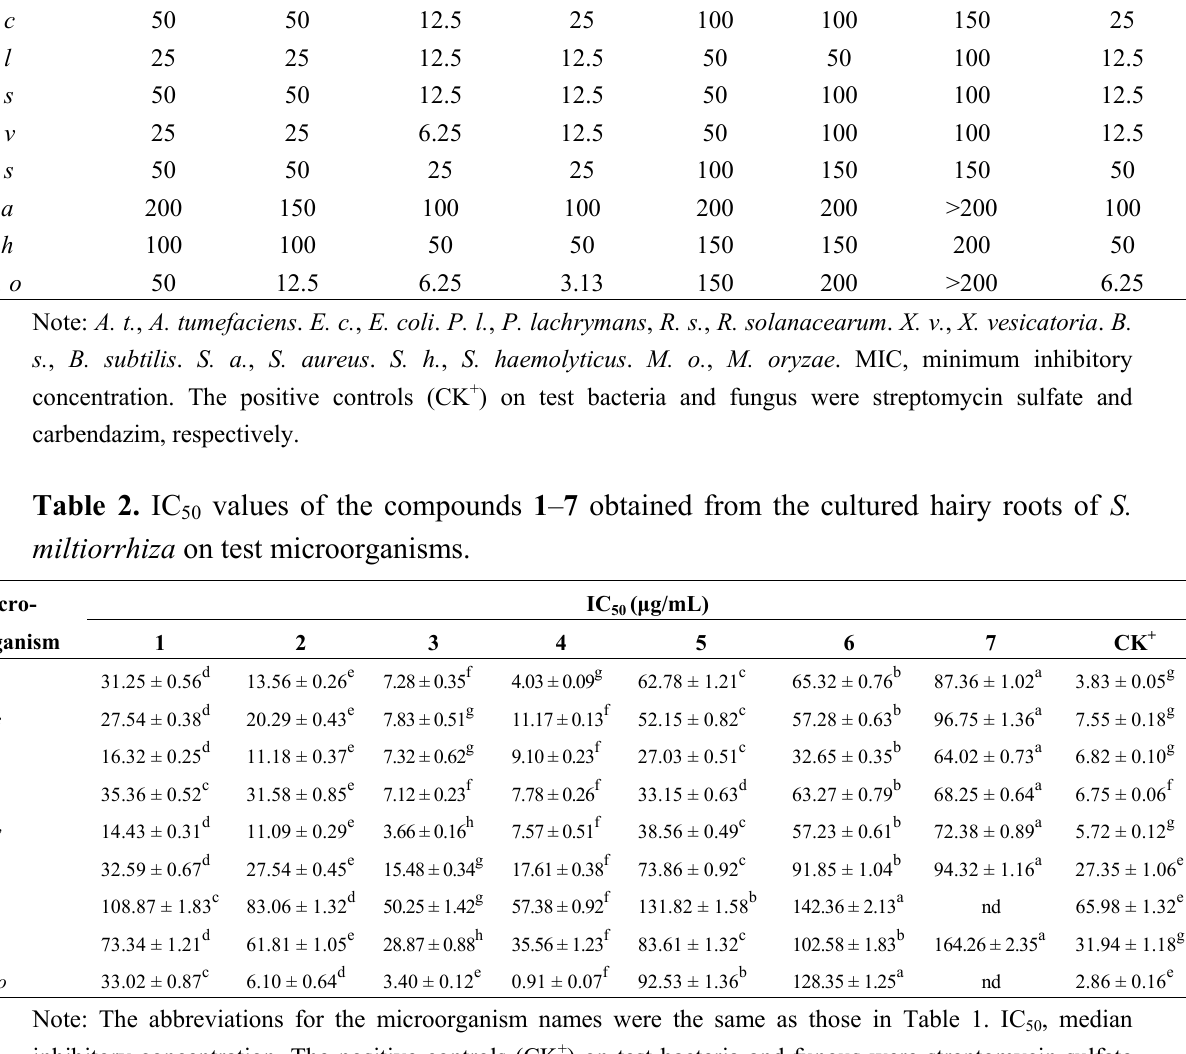
inhibitory concentration. The positive controls (CK + ) on test bacteria and fungus were streptomycin sulfate and carbendazim, respectively. The 'nd' means not detected. Mean ± standard deviation of three independent experiments (three replicates for each treatment). Different letters ( i.e. , a–h) indicated significant differences among the test compounds on a certain microorganism at p = 0.05